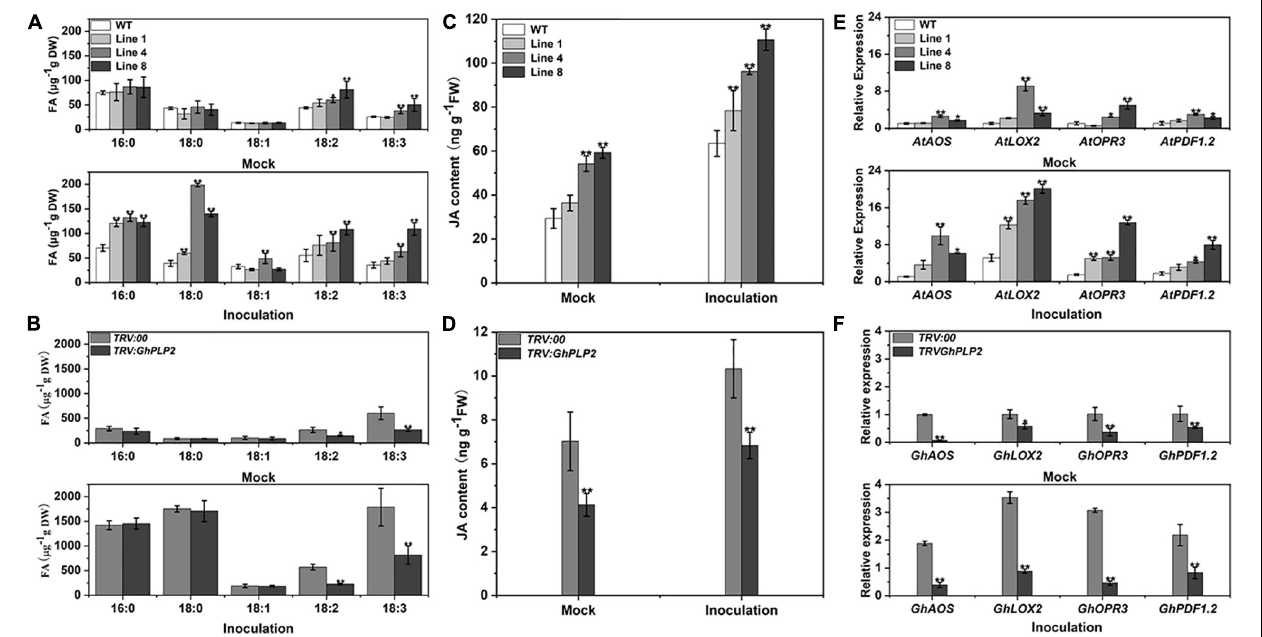
FIGURE 8 | The composition of fatty acids, accumulation with JA, and gene expression were determined in Arabidopsis and cotton plants 3 days after inoculation with water (mock) and Verticillium dahliae . (A) Analysis of the fatty acids composition in Arabidopsis plants 3 days after inoculation with water (mock) and V. dahliae . (B) Analysis of the fatty acids composition in cotton plants 3 days after inoculation with water (mock) and V. dahliae. (C) Accumulation of JA in Arabidopsis plants 3 days after inoculation with water (mock) and V. dahliae . (D) Accumulation of JA in cotton plants 3 days after inoculation with water (mock) and V. dahliae . (E) The relative level of expression of the genes associated with the JA signaling pathway in WT and GhPLP2 -overexpressed Arabidopsis plants 3 days after inoculation with water (mock) and V. dahliae . AtEF1 α (AT5G60390) was used as the standard internal gene. (F) The relative expression of genes associated with the JA signaling pathway in TRV:00 and GhPLP2 -silenced cotton plants 3 days after inoculation with water (mock) and V. dahliae . GhUBQ7 (DQ116441) was used as the standard internal gene. Data represent the means ± standard error of three independent biological repeats. Asterisks indicate a significant difference compared with WT or TRV:00 , respectively. ( *P < 0.05, **P < 0.01, Student’s t